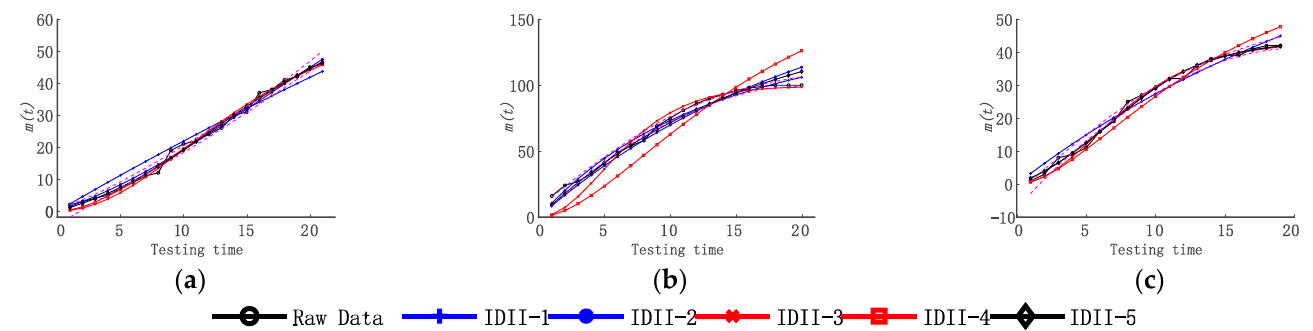
Figure 3. IDII Model Fitting Curve. ( a ) IDII Model Fitting Curve on DS1; ( b ) IDII Model Fitting Curve on DS2; ( c ) IDII Model Fitting Curve on DS3. Table 3. Performance comparison of IDII-type models.